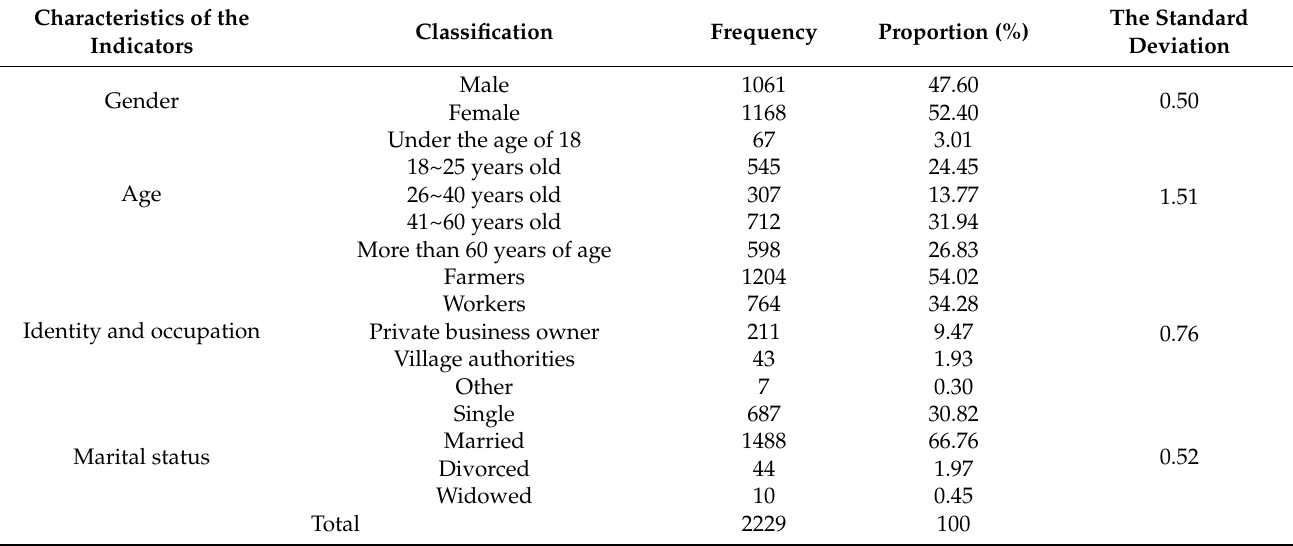
Table 2. Characteristics of